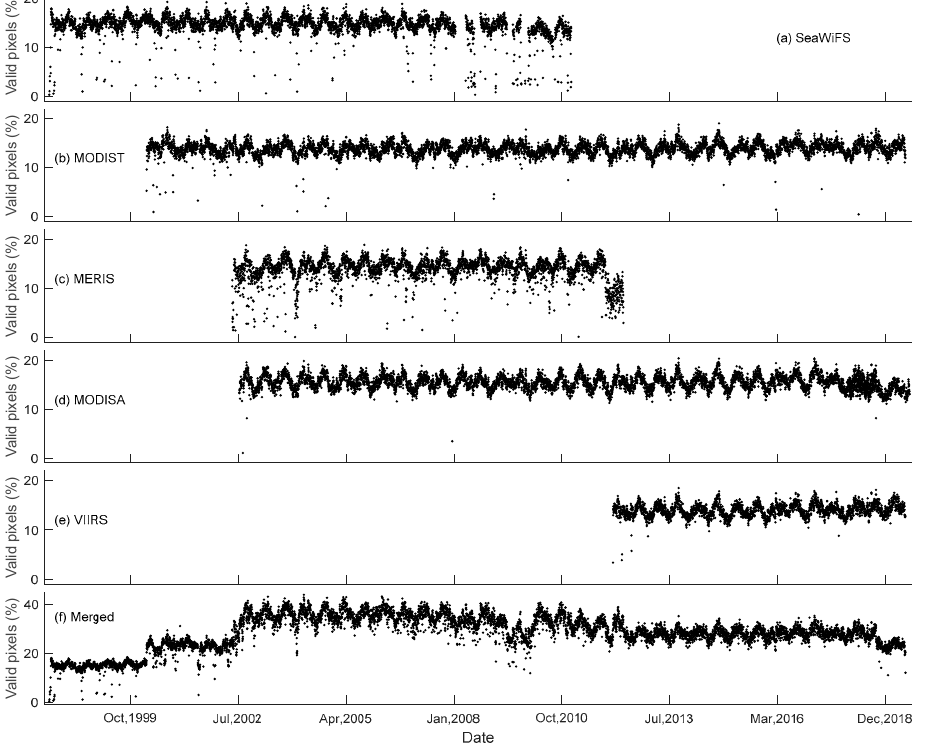
Figure 1. The percentage of valid pixels of daily Chl-a imagery for each satellite ( a – e ) and the data merged from five satellites ( f ).